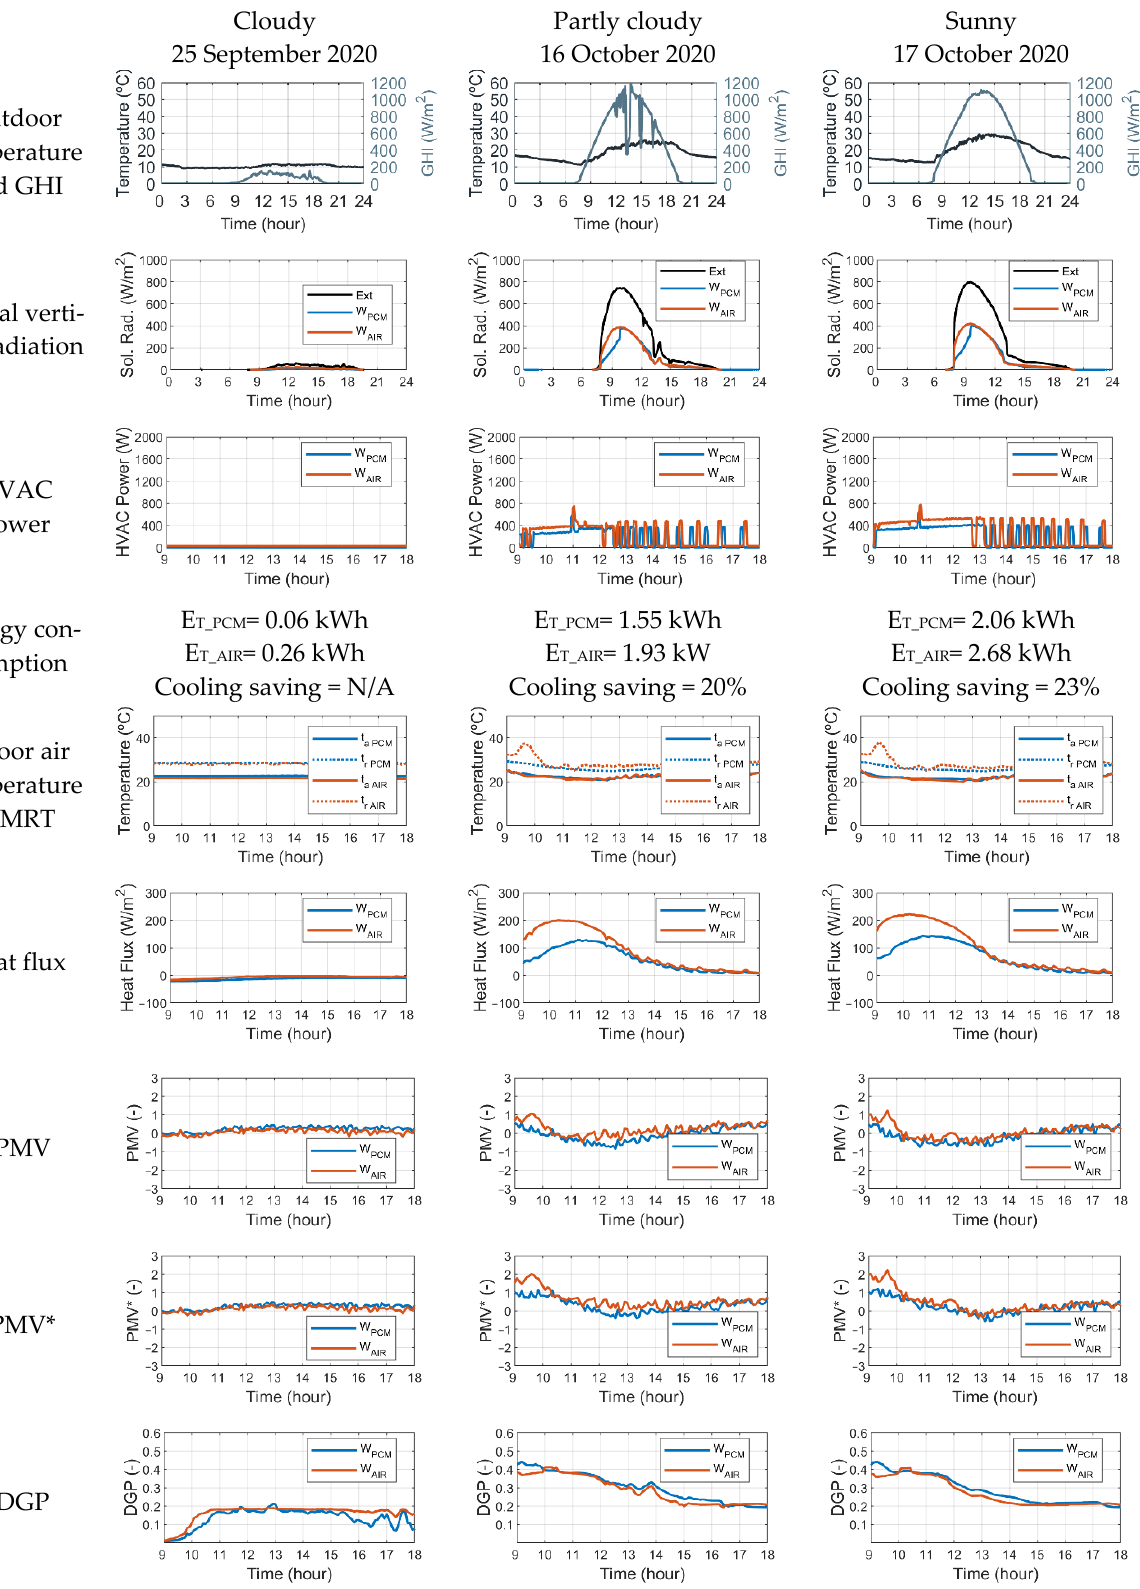
Figure 9. Results for representative days of summer. ( a ) Outdoor temperature and global horizontal radiation (GHI); ( b ) global vertical radiation; ( c ) HVAC power and energy consumption; ( d ) indoor air temperature & mean radiant tempera- ture (MRT); ( e ) heat flux; ( f ) PMV; ( g ) PMV*; ( h ) DGP. Cloudy Partly cloudy Sunny